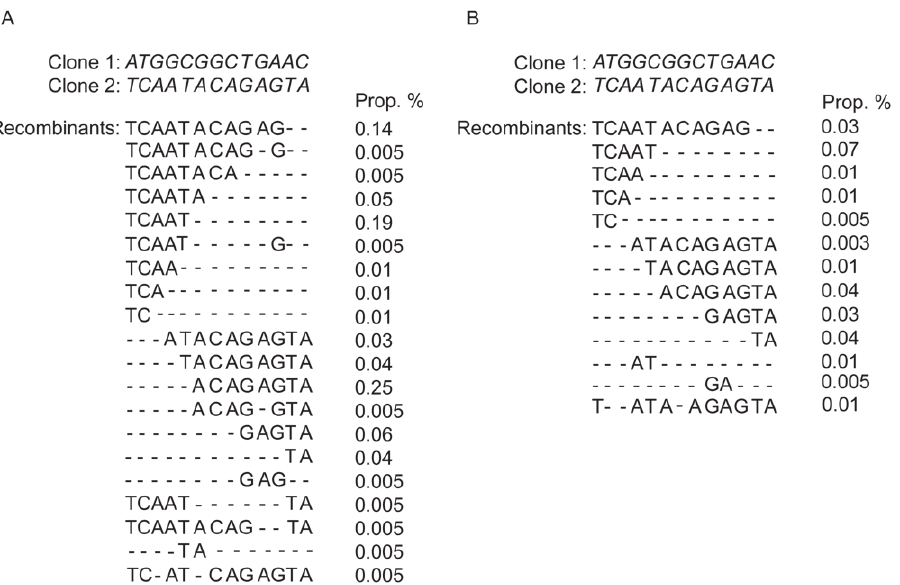
Figure 5. Analysis of invitro PCR recombination. The informative sites of clone 1 and clone 2 (see Figure 1) are shown in italics in the upper part of the figure. Below are identified recombinant reads presented for the experiment with 100,000 input template molecules (panel A) and 10,000 input template molecules (panel B). The proportion (Prop. %) of each recombinant is also shown.